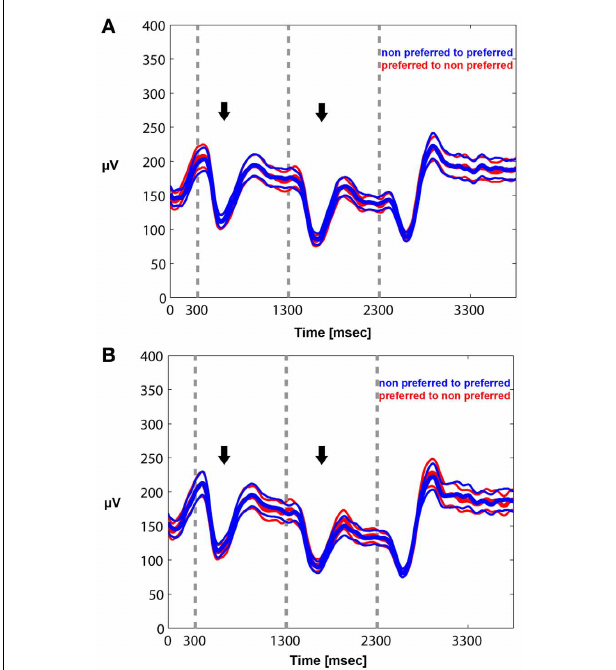
FIGURE 6 | Mean envelope (15–30Hz) across trials and recorded sites for PA (A) and BFS (B). In PA there is no difference in the modulation of beta power between a switch from a preferred to a non-preferred (red curve) and a switch from a non-preferred to a preferred (blue curve) visual stimulus. Stimulus-induced desynchronization (black arrows) followed by a beta rebound is observed in both cases. The same pattern is observed during BFS (B) . Note that in BFS from t = 1301–2300 there are no differences in beta power when the recorded neuronal population as well as the preferred pattern is dominant (blue) or suppressed